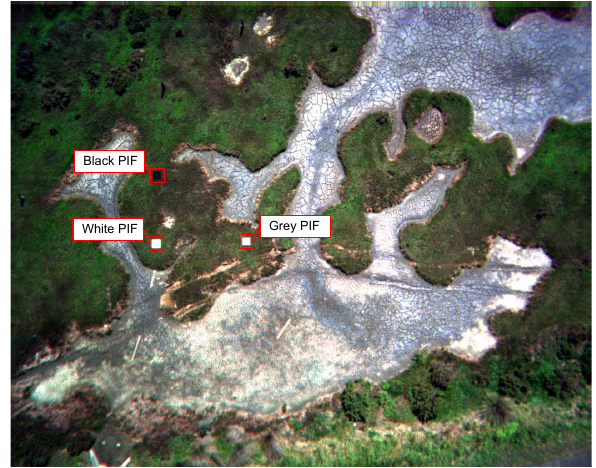
Figure 3: Uncorrected True Colour UAV Salt Marsh Test Image (Image Bands Coregistered)